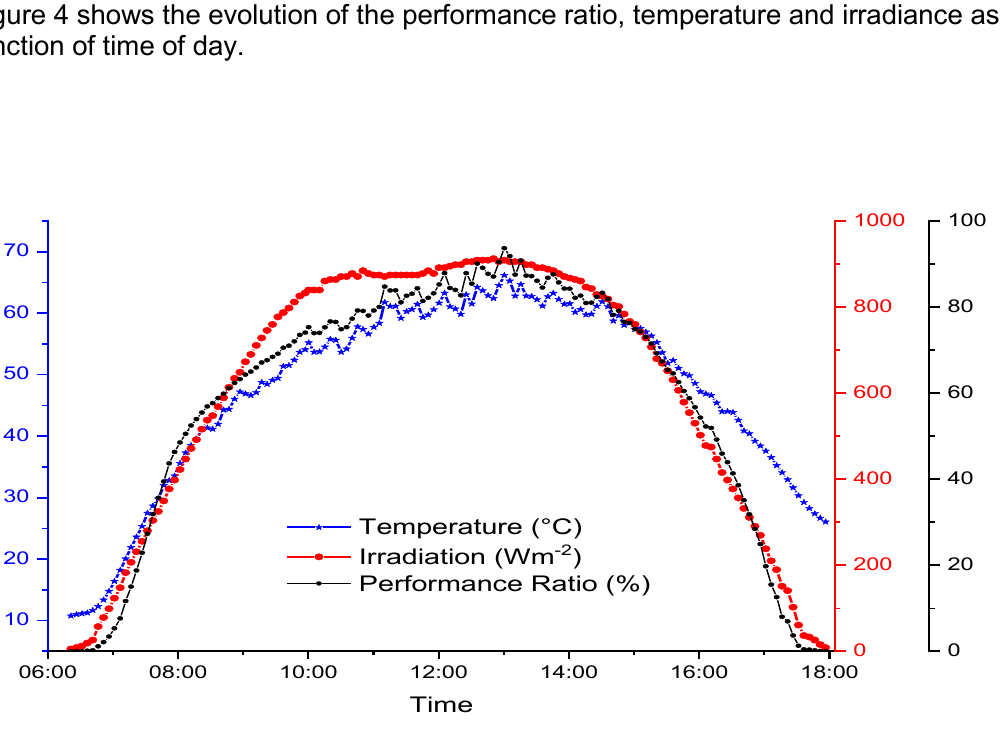
Figure 4. Evolution of the performance ratio during the day under clear